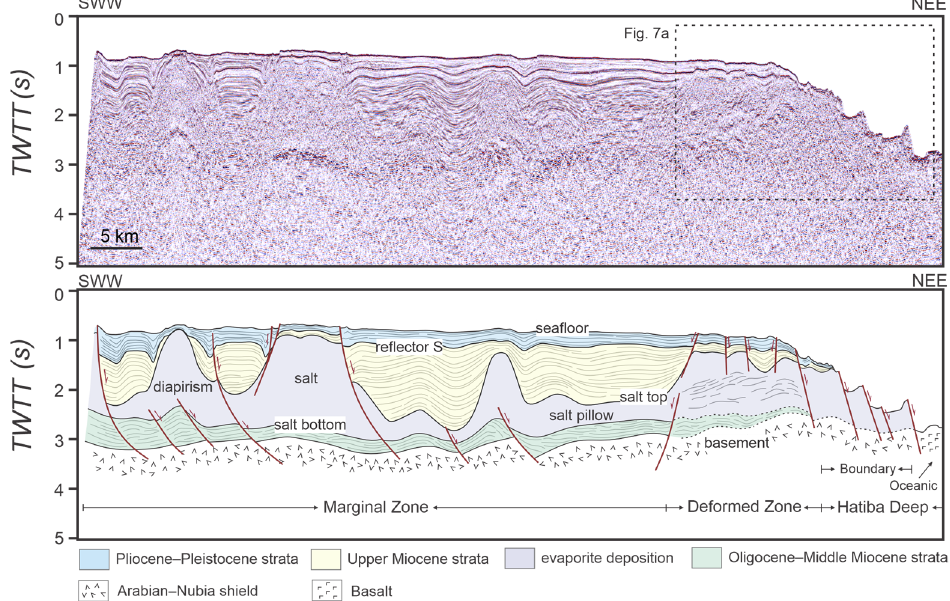
Figure 4. Re fl ection seismic pro fi le 060 and interpretations. Dashed box shows the area of Figure 7a. Figure 4. Reflection seismic profile 060 and interpretations. Dashed box shows the area of Figure